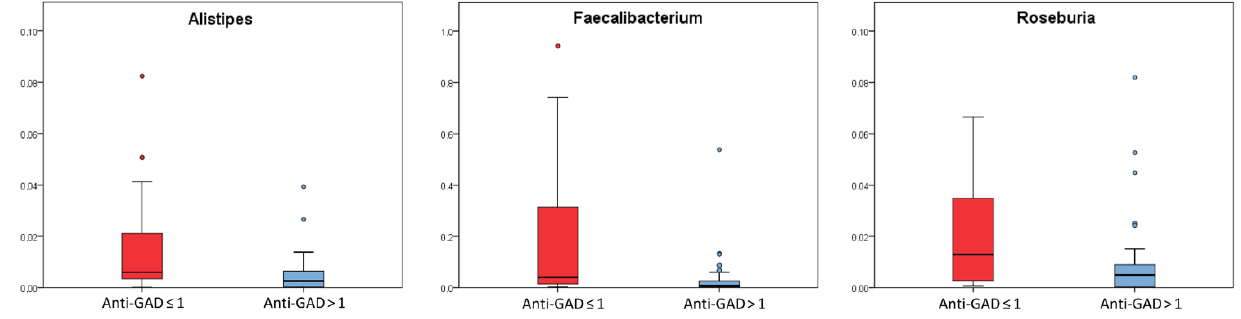
Figure 3. Box plots of the taxa selected basing on Kruskal – Wallis test ( p valu e ≤ 0 .05) for patients stratified by anti-GAD ≤ 1 (red box) and anti-GAD > 1 (light blue box). Box plots report median, minimum and maximum values, and the 25th and 75th percentile values of relative abundances of taxa.